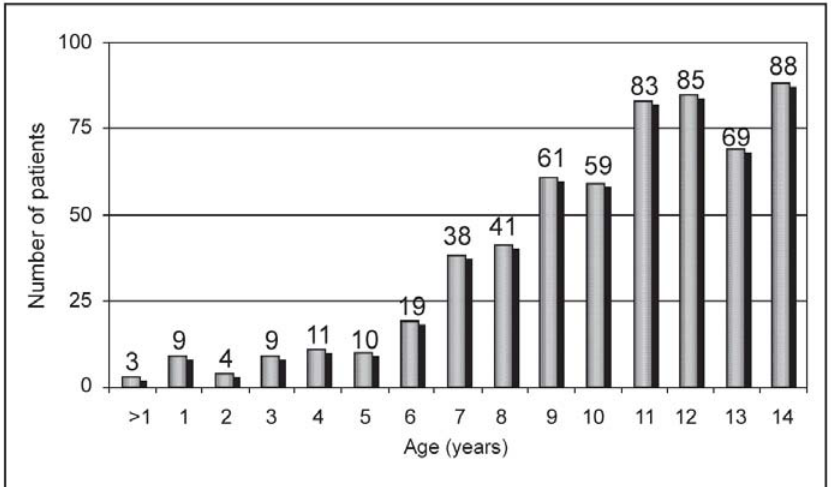
FIGURE 1- Patient distribution according to the